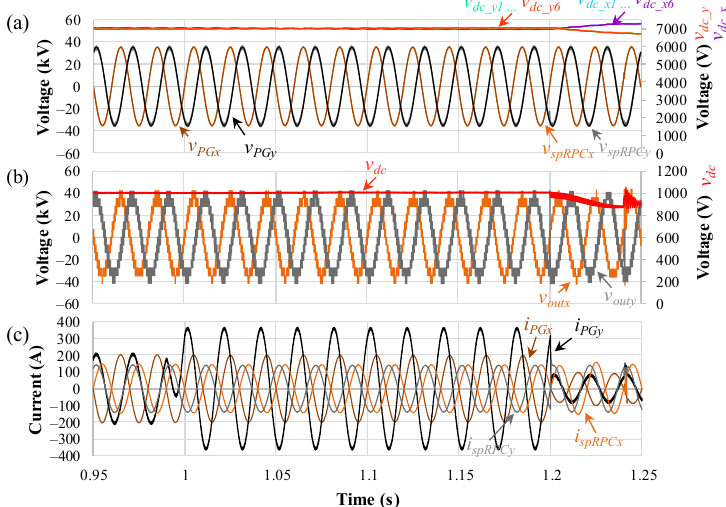
Figure 15. Detailed real-scale simulation results during the time interval from 0.95 s to 1.25 s: ( a ) the voltages on each TPS, v PGx and v PGy , the output voltages of the sp RPCx and sp RPCy , v spRPCx and v spRPCy , and voltages on the dc-link of each submodule, v dc_x1 to v dc_x6 , and v dc_y1 to v dc_y6 ; ( b ) the multilevel voltage of the spRPCx and spRPCy , v outx and v outy , and the voltage of the common dc-link voltage, v dc ; ( c ) the currents on each TPS, i PGx and i PGy , and the output currents of the sp-RPC, i spRPCx and i spRPCy . Figure 16 shows the result during the time interval from 1.95 s to 2.25 s, representa- tive of event (iii) in Figure 13. Figure 16a shows it is possible to verify the voltages of each TPS, v PGx and v PGy , as well as the voltages on each side of the sp-RPC, v spRPCx and v spRPCy . Moreover, it is possible to see that v dc_x6 has an average value of 7.06 kV, while v dc_y6 has an average value of 6.94 kV during this interval. The remaining voltages have similar values of the dc-link on the same side. In Figure 16b, the multilevel voltages v outx and v outy are